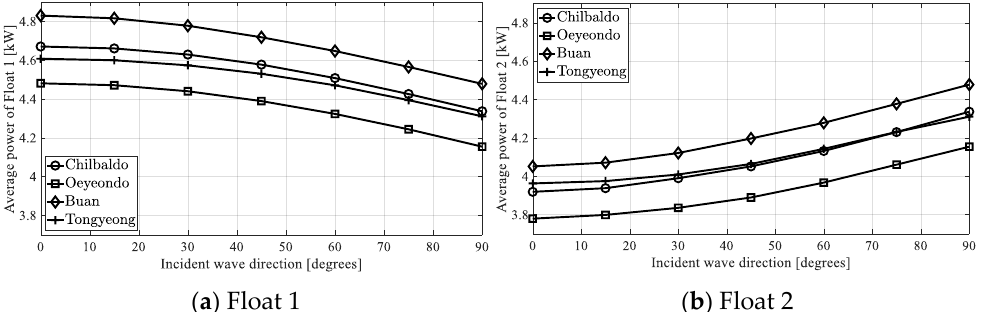
Figure 19. Comparison of average power production according to the incident wave directions at each location.